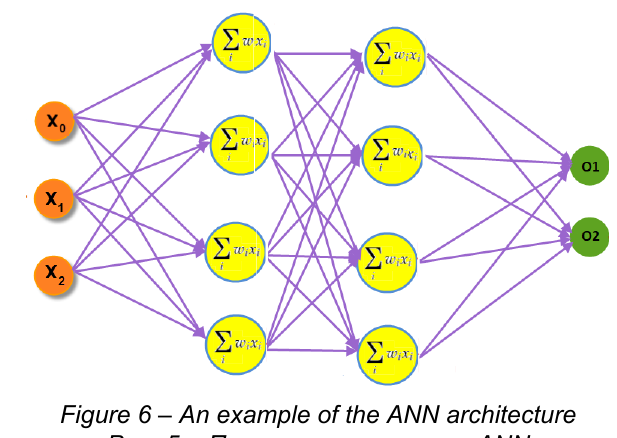
Figure 6 – An example of the ANN architecture Рис. 5 − Пример архитектуры ANN Слика 5 – Пример архитектура вештачке неуралне